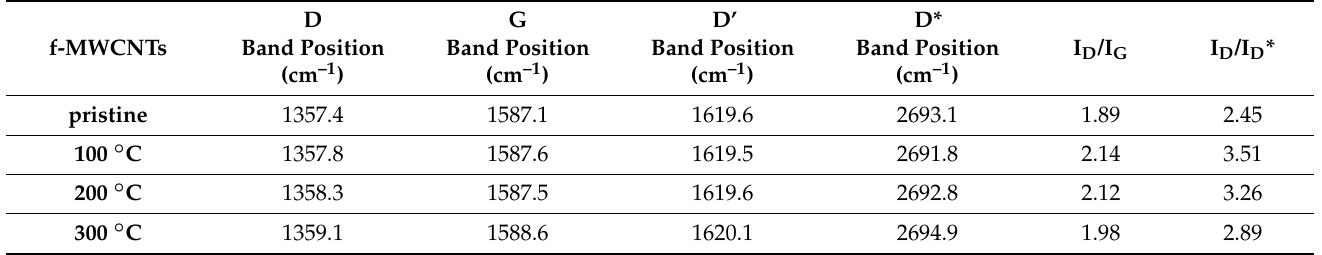
Table 1. Gaussian and Lorentzian fitting results of Raman spectra taking into account bands D, G, D (cid:48) , and D*, the intensity ratio of I D /I G , I D /I D *, and FWHM of pristine and calcinated carbon